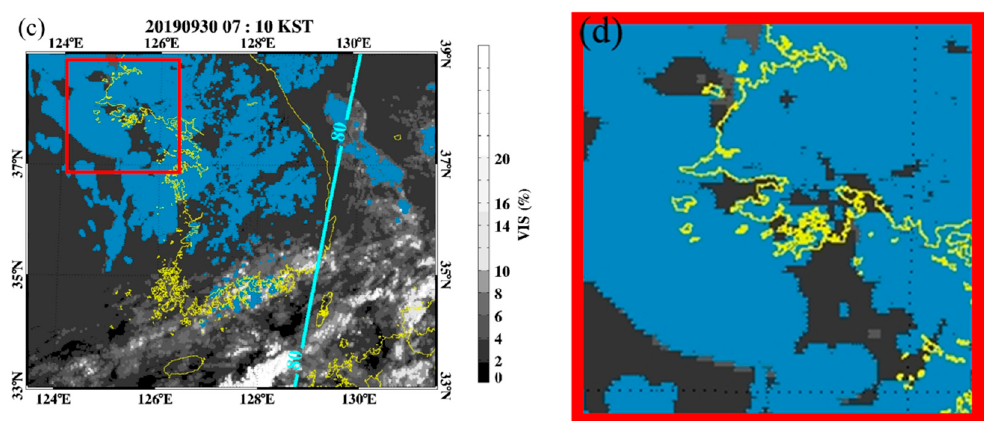
Figure 13. Sample images of spatio-temporal discontinuities obtained from ( a ) 06:10 KST to ( b ) 06:20 KST on 14 July 2019 and at ( c ) 07:10 KST on 30 September 2019). Bright sky blue lines indicate the SZA. ( d ) An enlarged picture of the red box area shown in ( c ).